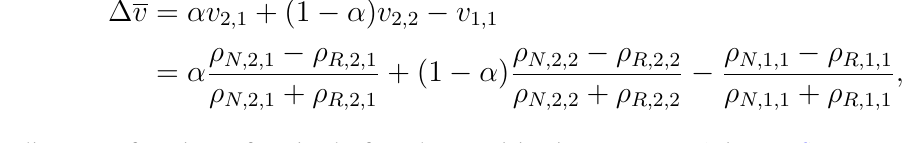
Figure 5. Illustration of the variables used in this study. v at the j -th resolution. v indicates the NDVI calculated for pixel k under the j -th resolution. j,k (cid:26)(cid:26)(cid:26) is the reflectance spectrum of pixel k at a resolution of j and is a linear combination of j,k the vegetation and non-vegetation endmember spectra, (cid:26)(cid:26)(cid:26)